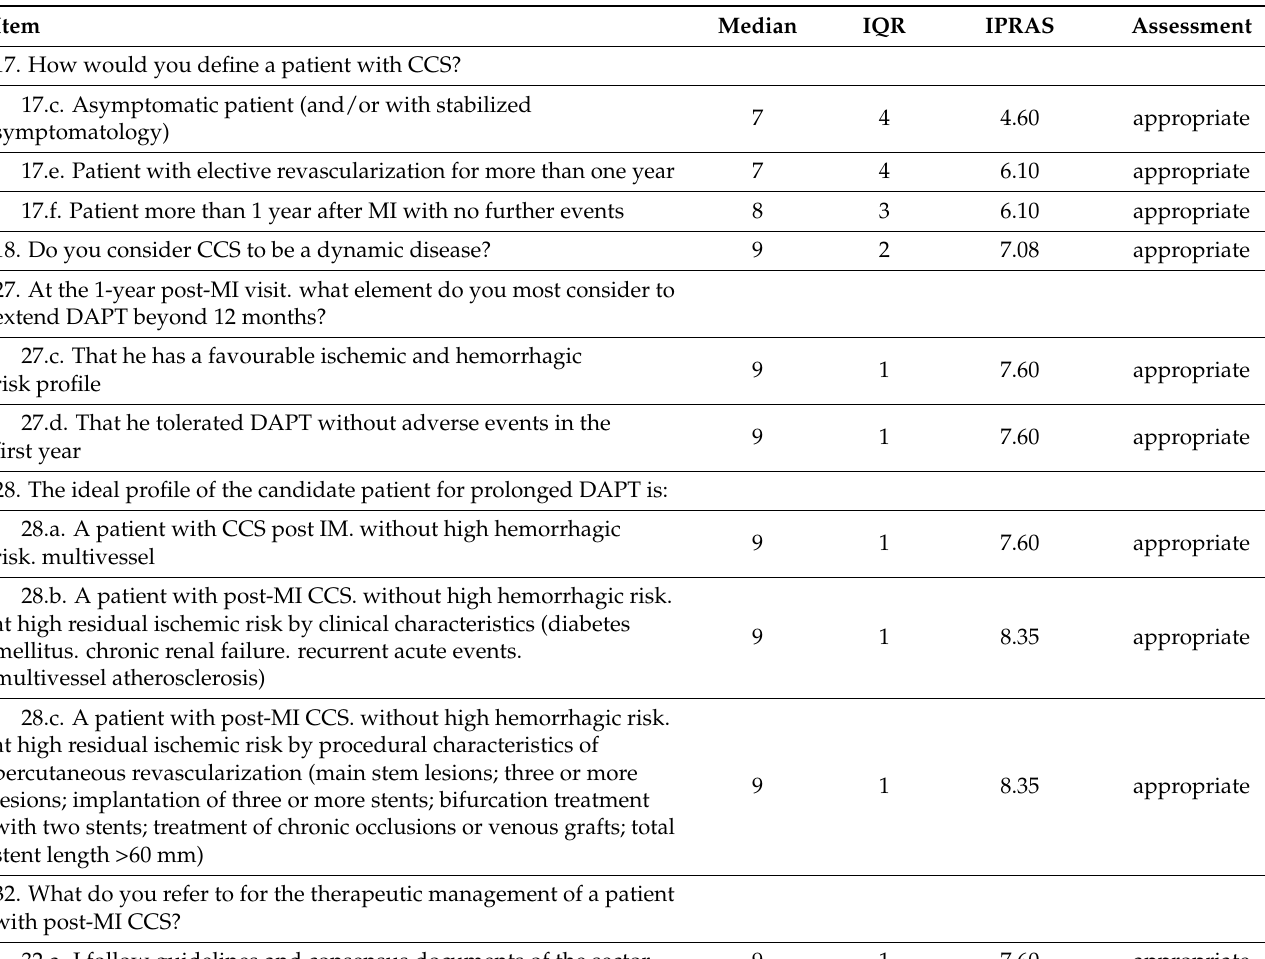
Table 2. Appropriateness Indexes evaluated according to the RAND/UCLA